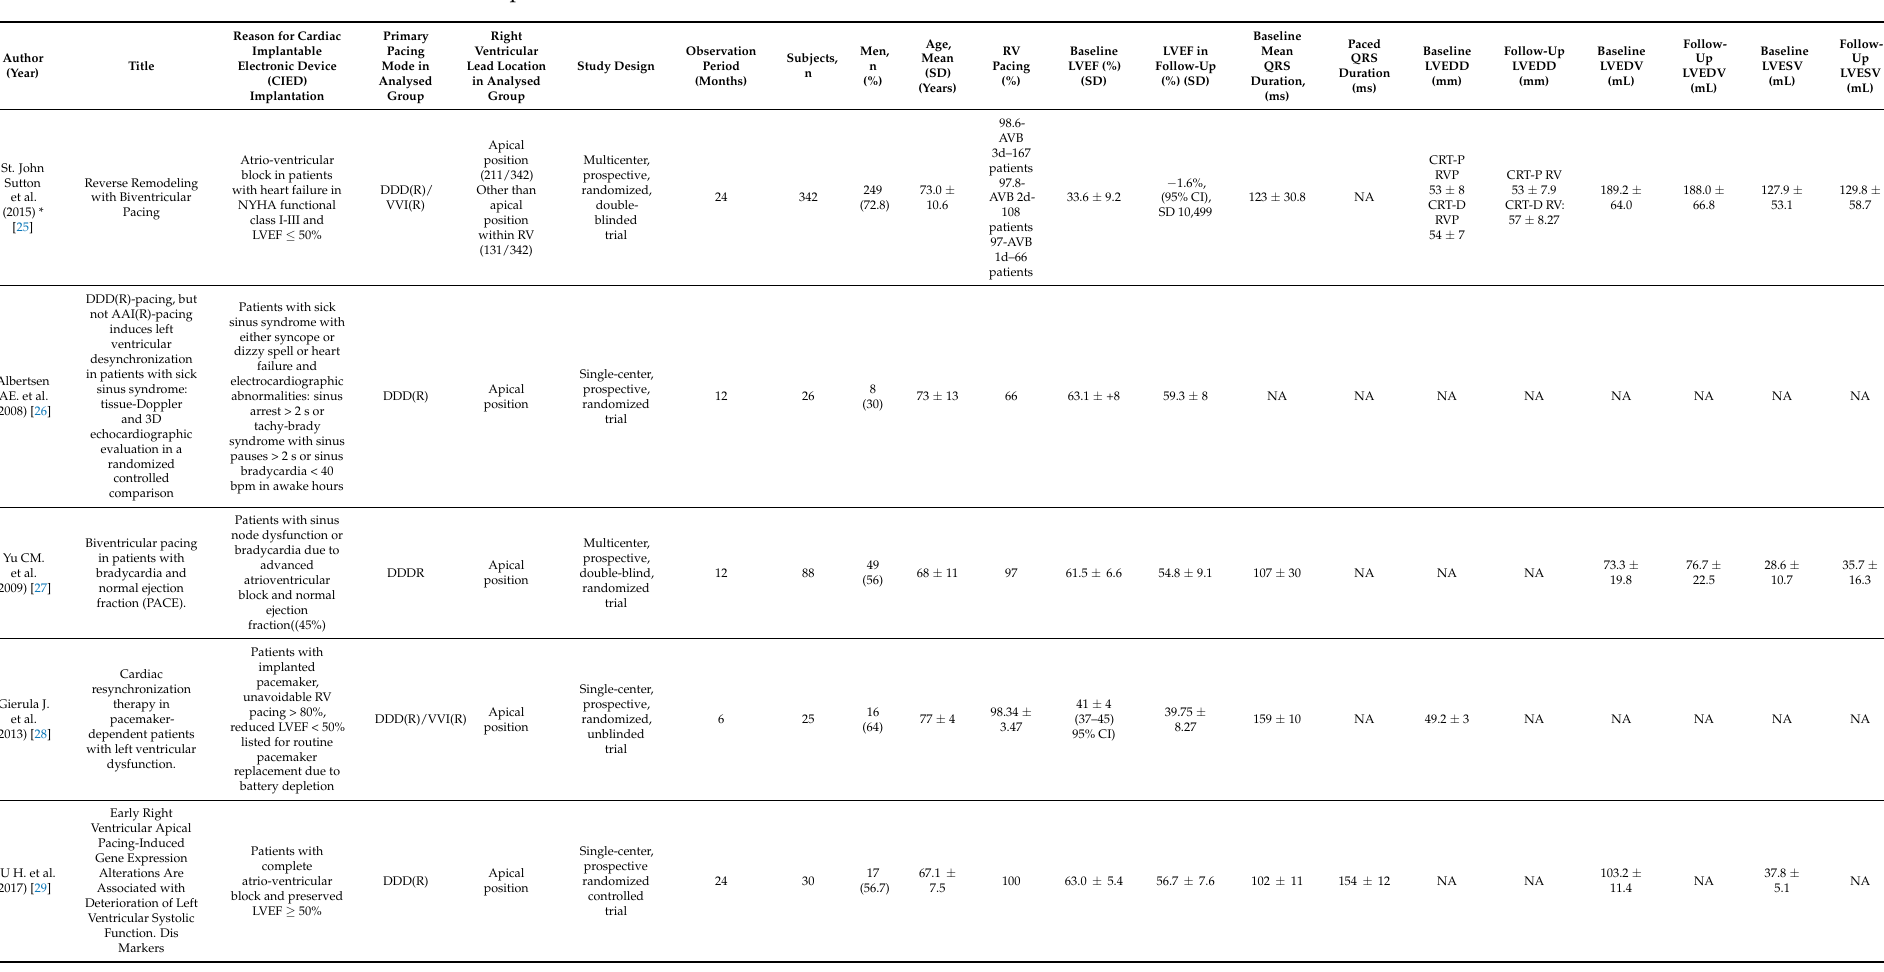
Table 1. Studies and patient